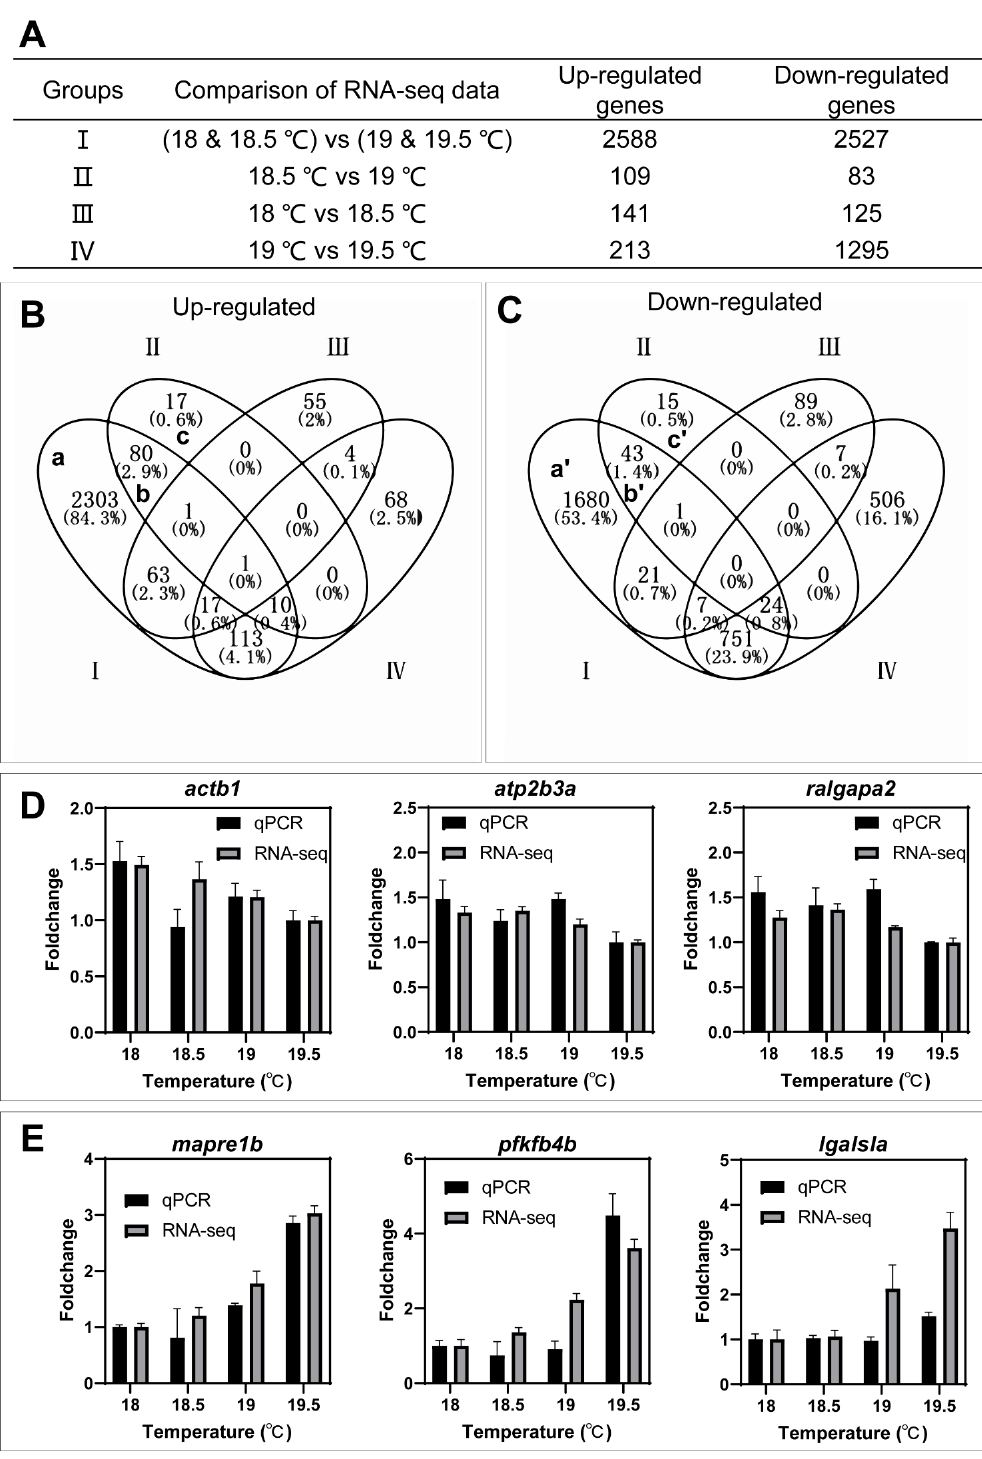
Figure 3. Identification of key genes associated with the spawning of females using Venn diagram. ( A ) The number of differentially expressed genes between groups of different temperatures (fold change ≥ 1.5 and p - value ≤ 0.05). ( B ) Up-regulated genes in different Venn groups to identify key genes between non-spawning and egg-spawning groups I and II (a, b, and c). ( C ) Down-regulated genes in different Venn groups to identify key genes between non-spawning and egg-spawning groups I and II (a’, b’ and c’). ( D ) Validation of RNA-seq data by qPCR for three genes from the group of up-regulated genes in groups I and II (a, b, and c). ( E ) Validation of RNA-seq data by qPCR for three genes from the group of down-regulated genes in groups I and II (a’, b’ and